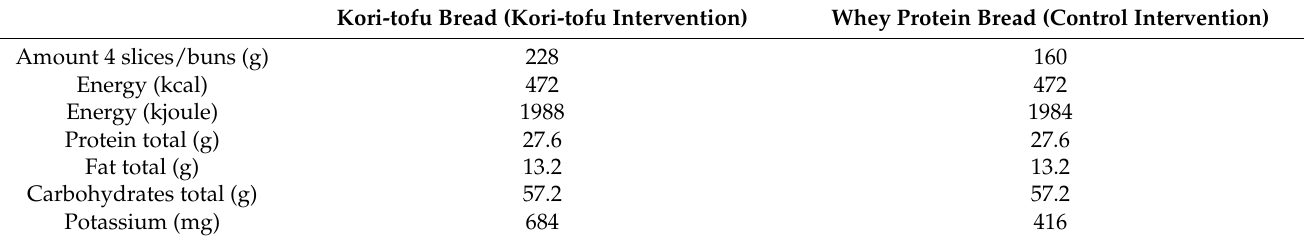
Table 1. Energy and macronutrient content of 4 slices or buns of bread (Kori-tofu and whey protein), based on raw